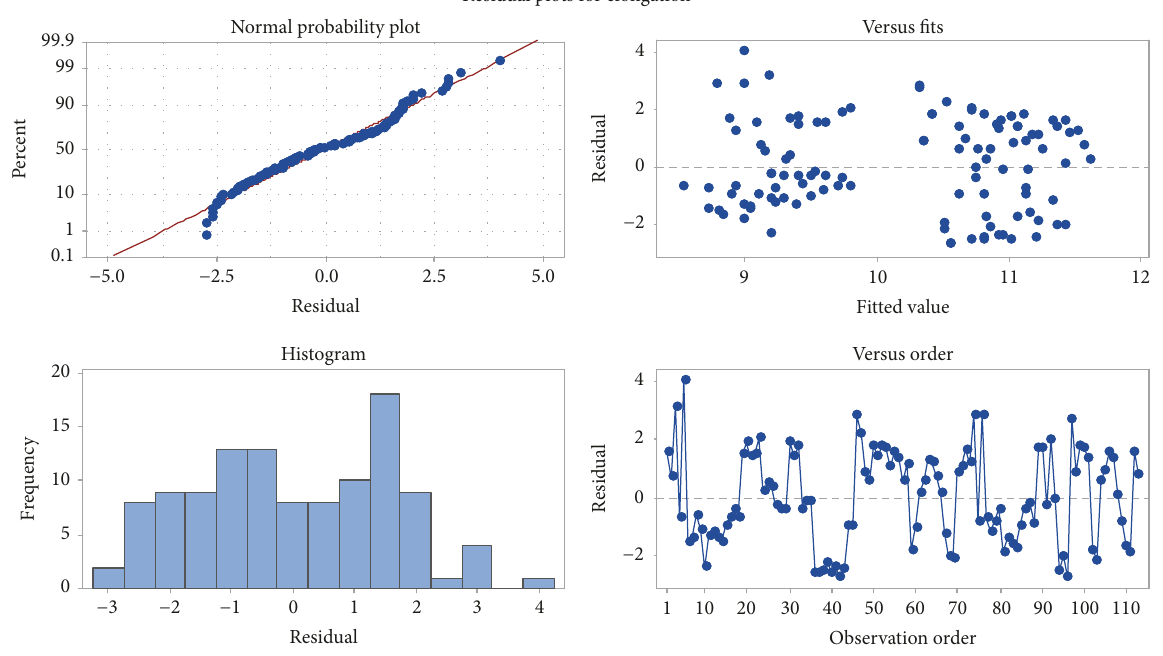
Figure 5: Residual plots of elongation using linear regression method.